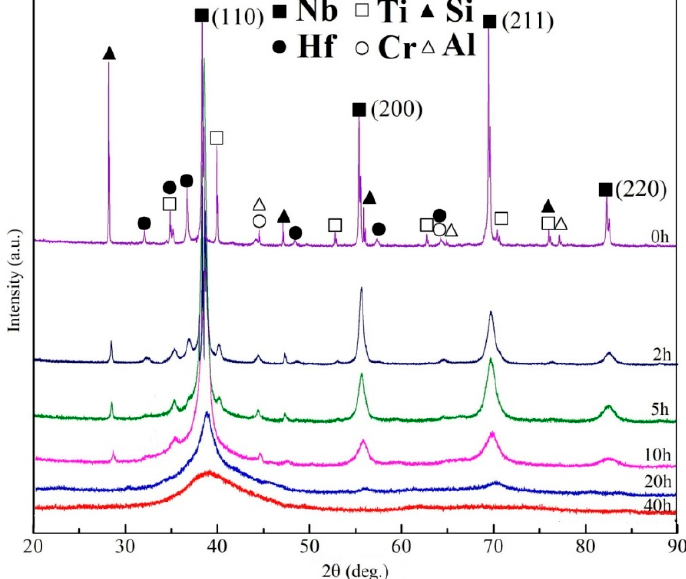
Figure 3. XRD patterns of the powder particles after ball milling for different times at 500 rpm.